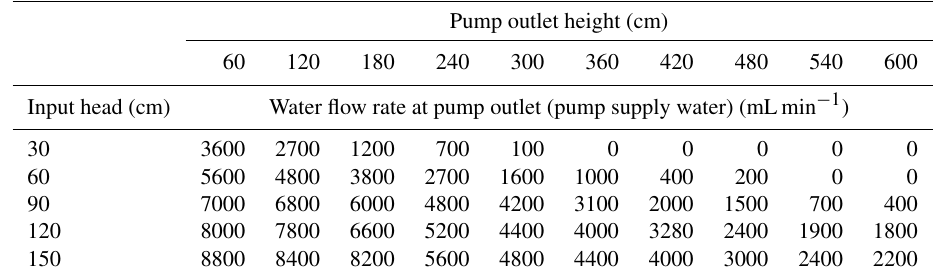
Table 2. The pump output water flow rate variation with input head and outlet height.